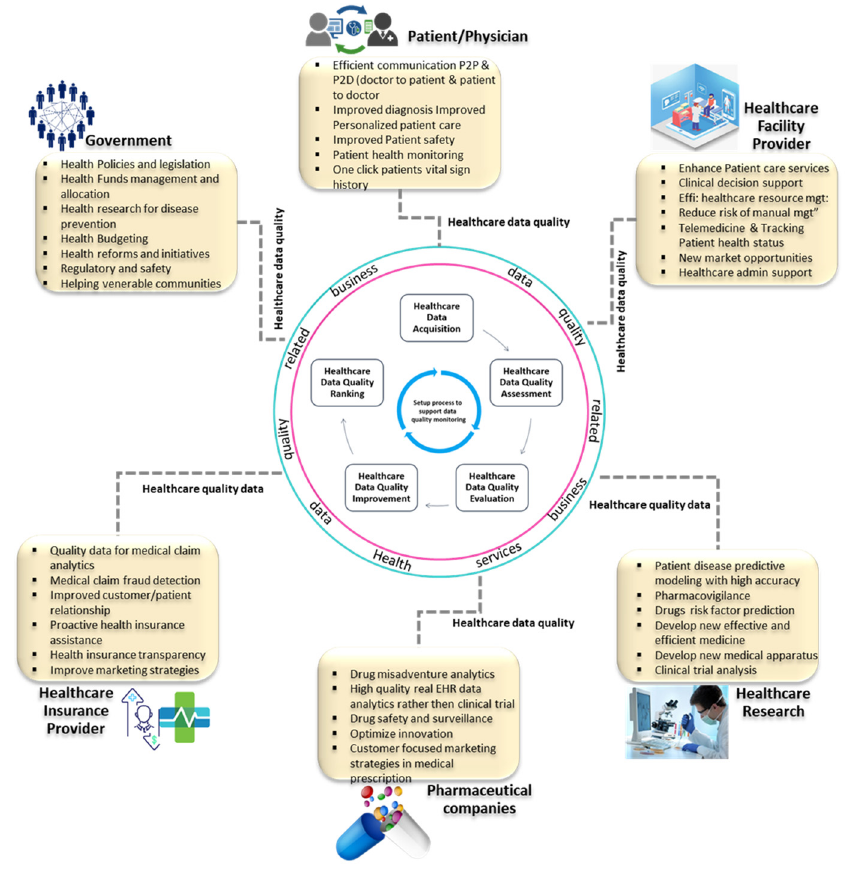
Figure 1. Contextual data quality environment in the healthcare domain.